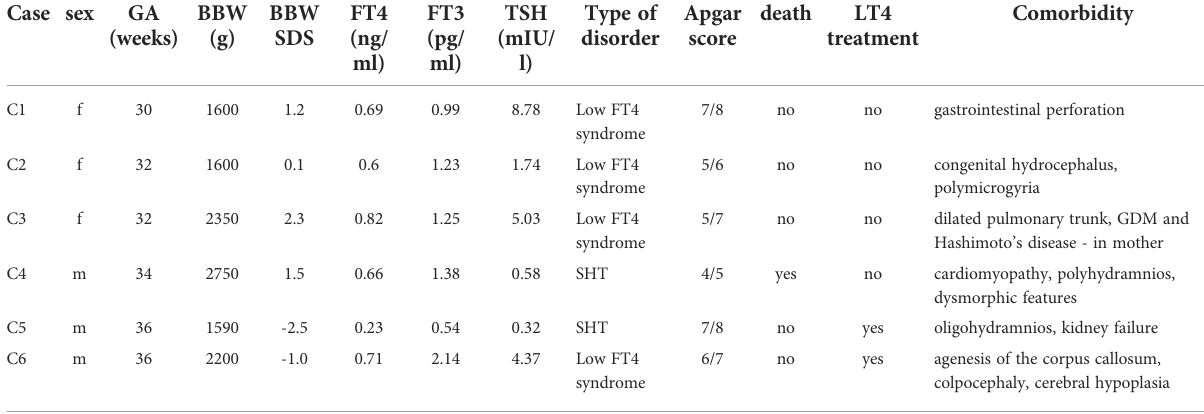
TABLE 4 Detailed data on fi ve children with hypothyroxinemia, born between 32 nd and 37 th week and one child born in the 30 th week, but with the birth weight over 1500 g (GA, gestational age; BBW, birth body weight; SDS, standard deviation score; SHT, secondary hypothyroidism; GDM, gestational diabetes